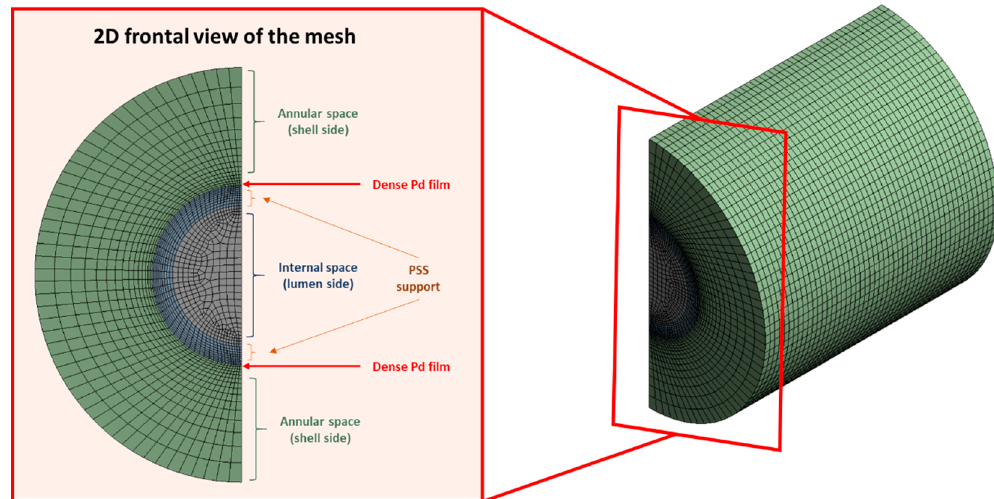
Figure 2. Illustrative mesh details for the membrane permeator for the out–in configuration.